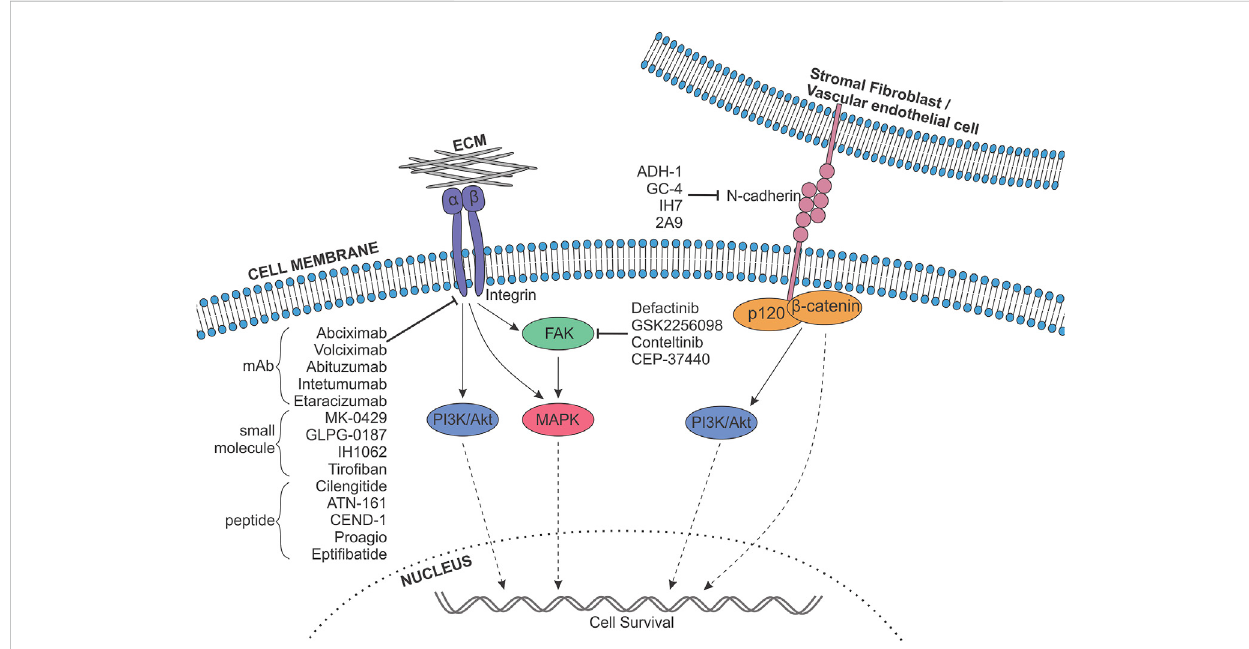
FIGURE 3 Targeting adhesion molecules in melanoma anoikis resistance. A range of integrins, as well as N-cadherin, and their downstream signalling pathways, including FAK (green), Mitogen-Activated Protein Kinase (MAPK; pink), PI3K-Akt (purple) and catenin pathways (orange), are known to contribute to anoikis resistance in melanoma. Pharmaceutical inhibitors targeting integrins, cadherins and FAK exist, and have the potential to be repurposed to block melanoma cell survival upon detachment. Different classes of integrin inhibitors are shown, mAb, monoclonal antibody; ECM, Extracellular matrix. Indicated inhibitors have been sourced from data from all